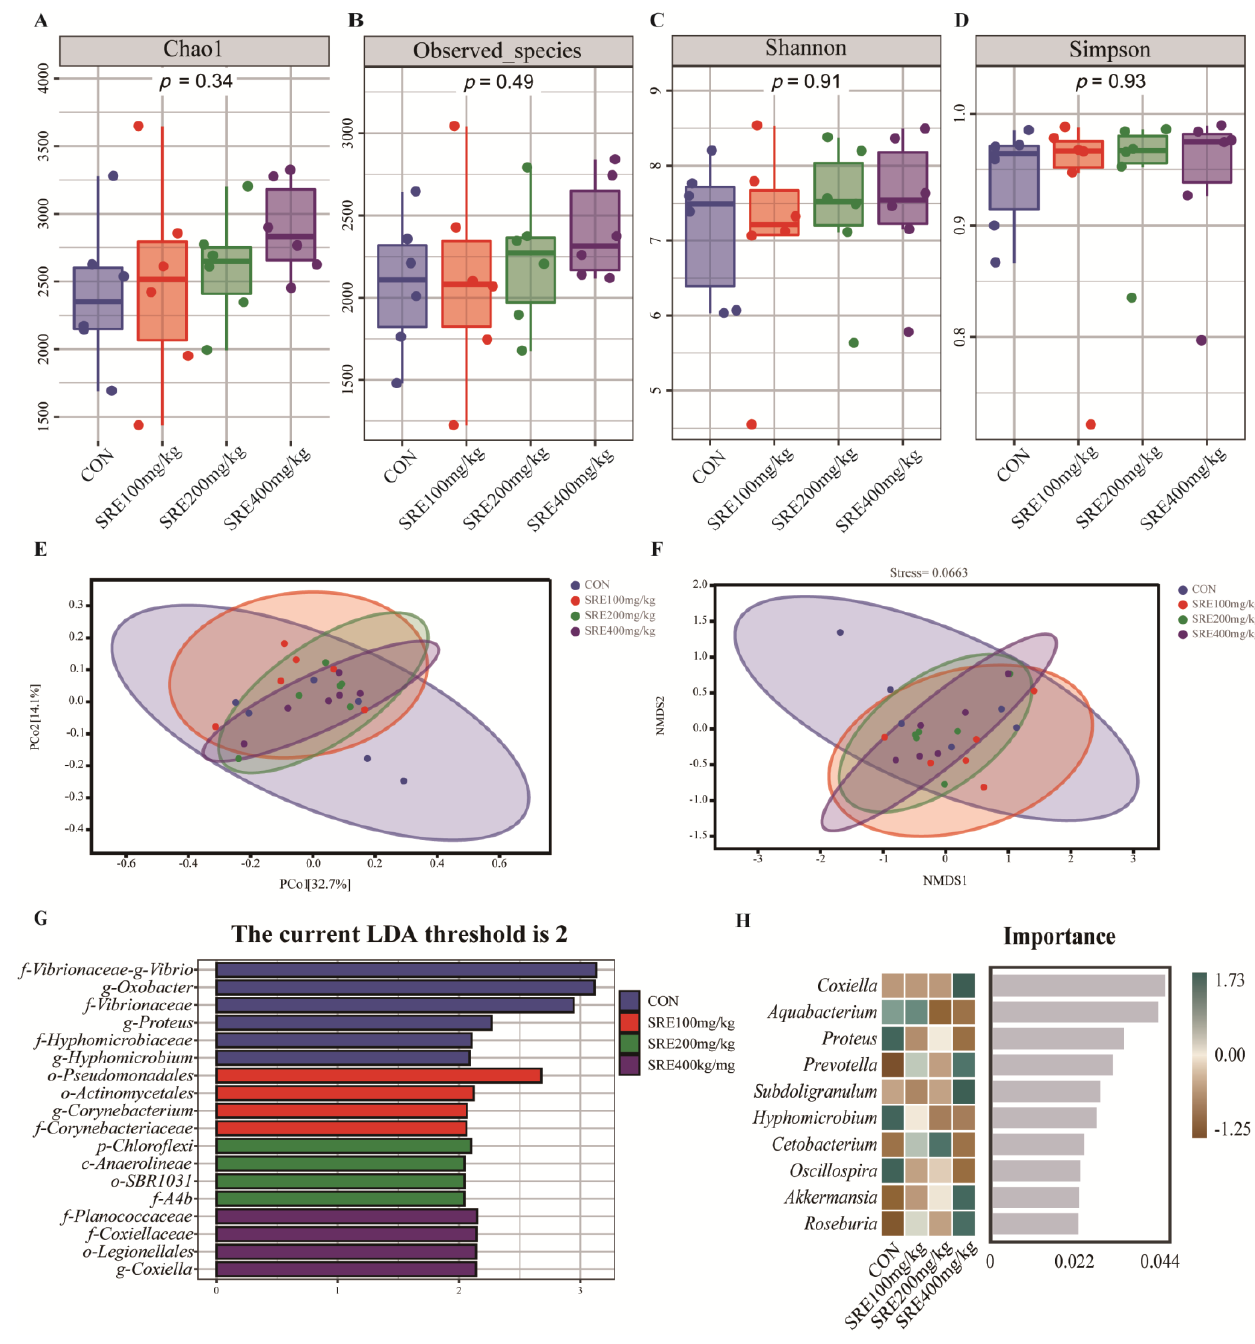
Figure 2. Effects of supplementation of diets with stevia residue extract on colonic microbial diversity of weaned piglets on day 42 of the trial. Comparison of alpha diversity index (Chao1 index, Good’s coverage index, Shannon index, Simpson index ) among the three groups ( A − D ). Bray − Curtis distance-based principal coordinates analysis ( E ). Bray − Curtis distance-based nonmetric multidimensional scaling plot ( F ). The LEfSe analysis (LDA score ≥ 2) identified the biomarker bacterial species in the three groups ( G ). Top 10 marker species in each group at the genus level were analyzed using Random Forest Classifier ( H ). Con: control group without the supplementation of stevia residue extract in the diet; SRE100 mg/kg: diets supplemented with 100 mg/kg stevia residue extract group; SRE200 mg/kg: diets supplemented with 200 mg/kg stevia residue extract group; SRE400 mg/kg: diets supplemented with 400 mg/kg stevia residue extract group.